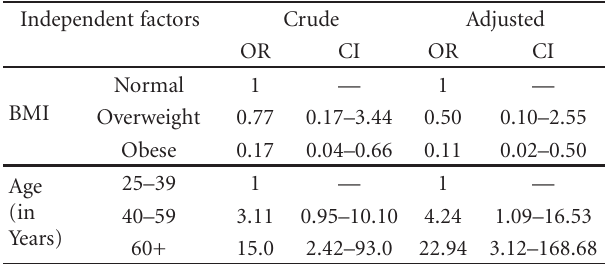
Table 4: Crude and adjusted odds ratio of independent